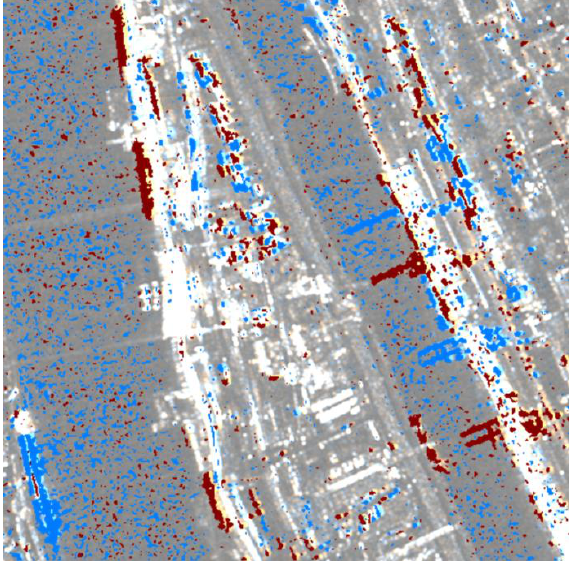
Figure 13. Automatically detected changes over 10 dB using pixel-based log-ratio with the amplitude image in the background.